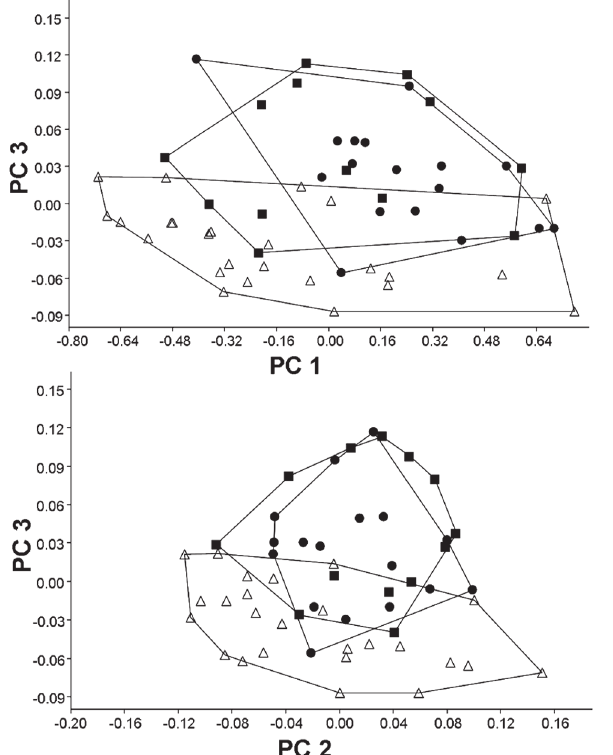
Fig. 3. Plots of factor scores of principal component analysis of three populations of Aspidoras albater , with all measurement included. Circle, Anésio III Cave; Square, Russão II Cave; triangle, epigean specimens.